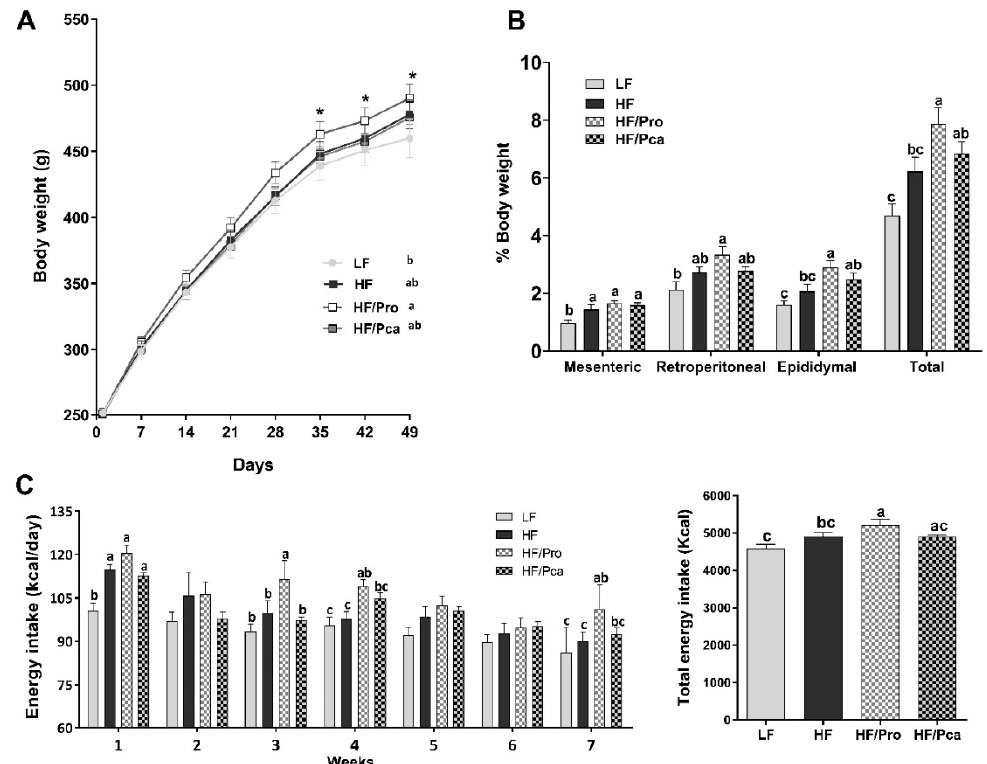
Figure 1. Non-encapsulated or encapsulated probiotic supplementation had no protective effects on obesity phenotype. Bodyweight ( A ), adiposity index: Fat pad weight/BW (%) ( B ) and energy intake ( C ) of rats fed an LF, HF, HF/Pro, or HF/Pca diet for seven weeks. Values are means ± SEMs; n = 8/group. a,b,c means with different letters are statistically significant, * indicates p < 0.05. HF, high fat; HF, high fat; HF/Pca, HF with supplemented with encapsulated L. casei W8 (4 × 10 7 cfu/g diet); HF/Pro, HF supplemented with non-encapsulated L. casei W8 (4 × 10 7 cfu/g diet); LF, low fat.